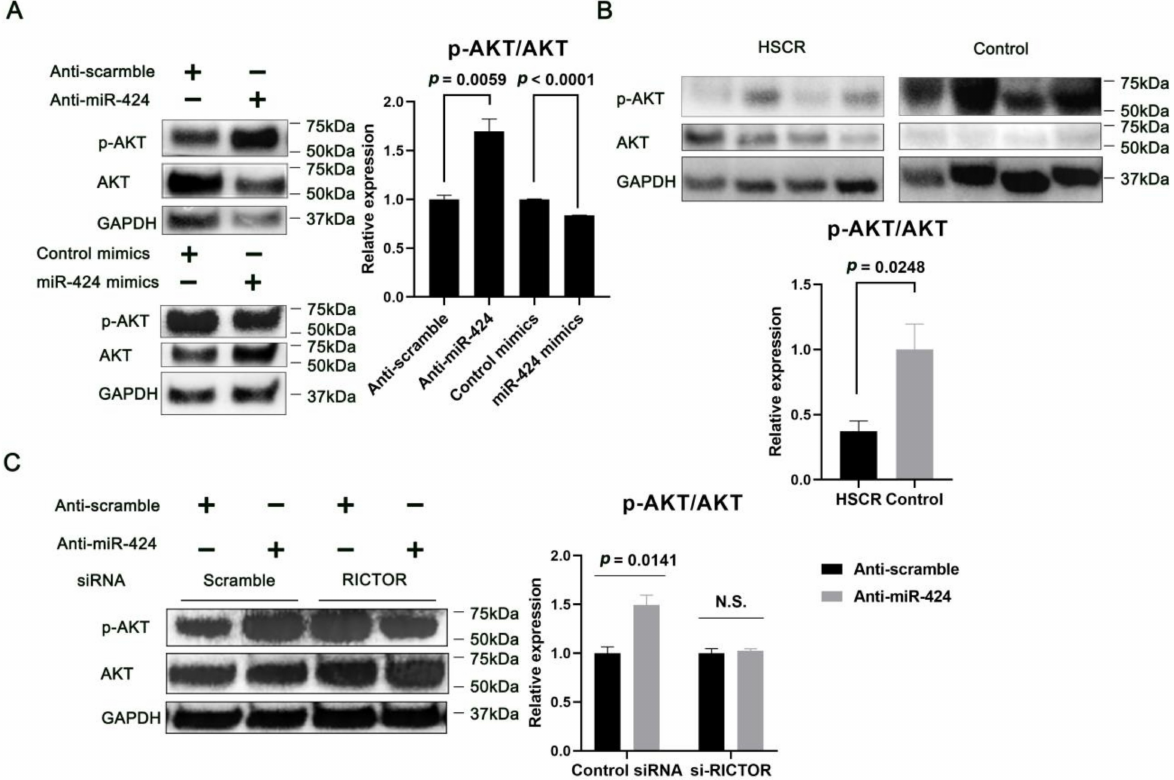
Figure 6. miR-424 modulates AKT phosphorylation via RICTOR. ( A ) The effects of miR-424 on AKT phosphorylation in human neural cells. SH-SY5Y cells were transfected with miR-424 mimics, anti-miR-424, or the corresponding controls. AKT phosphorylation at Ser473 (p-AKT) was assessed by Western blotting 72 h post-transfection. Representative blots are present. GAPDH serves as a loading control. Error bar = SEM (standard error of the mean); n = 3. ( B ) Western blot analysis of AKT phosphorylation in the colonic tissues from patients with HSCR ( n = 4) and controls ( n = 4). Error bar = SEM. ( C ) Knock-down of RICTOR rescues the anti-miR-424-induced increase in AKT phosphorylation. SH-SY5Y cells were co-transfected with anti-scramble or anti-miR-424, and con- trol siRNA or siRNA cognate to RICTOR for 72 h. Representative blots show the levels of AKT phosphorylation. Error bar = SEM; N.S., not significant; n =